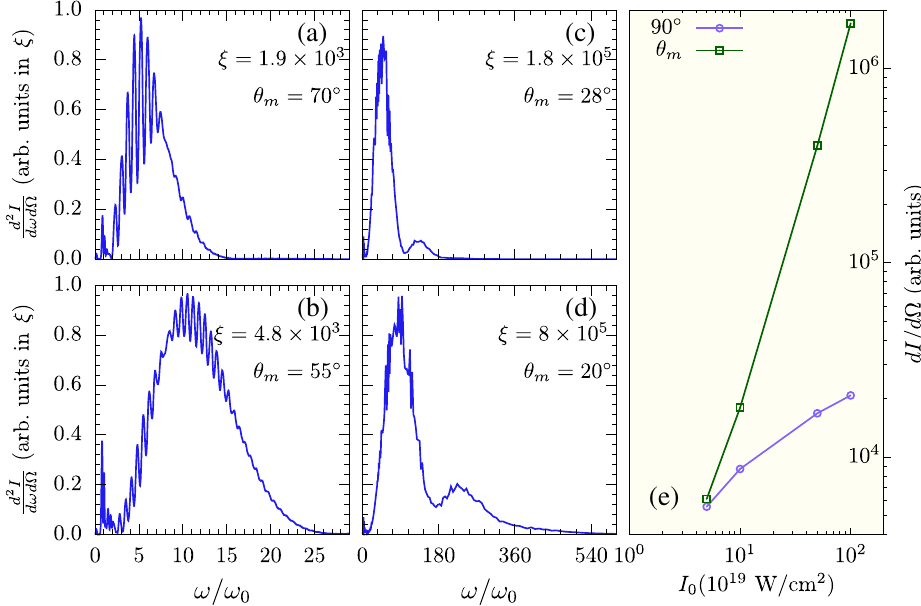
FIG. 5. Radiation spectra emitted by the electrons have been plotted for I ¼ 5 × 10 19 W = cm 2 (a), 1 × 10 20 W = cm 2 (b), 5 × 10 20 W = cm 2 (c) and 1 × 10 21 W = cm 2 (d). The frequency integrated energy per unit solid angle ( dI=d Ω ) for different intensities of laser pulse is also plotted (e). The radiation spectra in (a),(b),(c), and (d) are calculated for θ ¼ θ m and ϕ ¼ 180 °. However, dI=d Ω in (e) is presented for both θ ¼ 90 ° and θ m